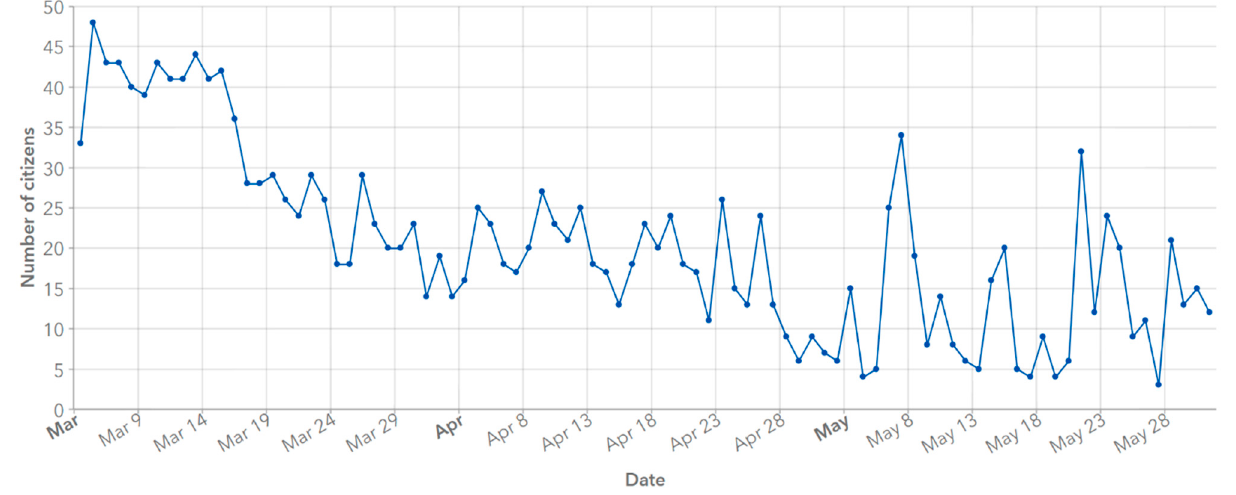
Figure 4. Citizen activity curves during the field data collection campaign.